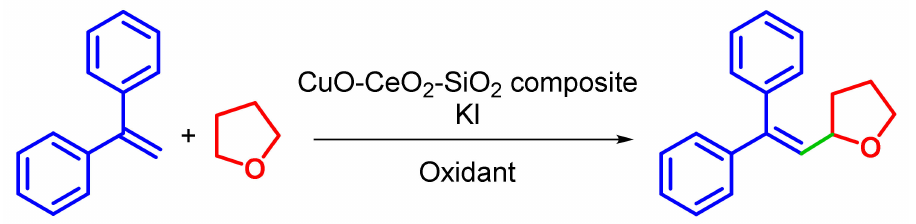
Figure 5. The cross-dehydrogenative coupling of 1,1-diphenylethyle-ne with tetrahydrofuran cat- alyzed by the CuO-CeO 2 -SiO 2 composite.